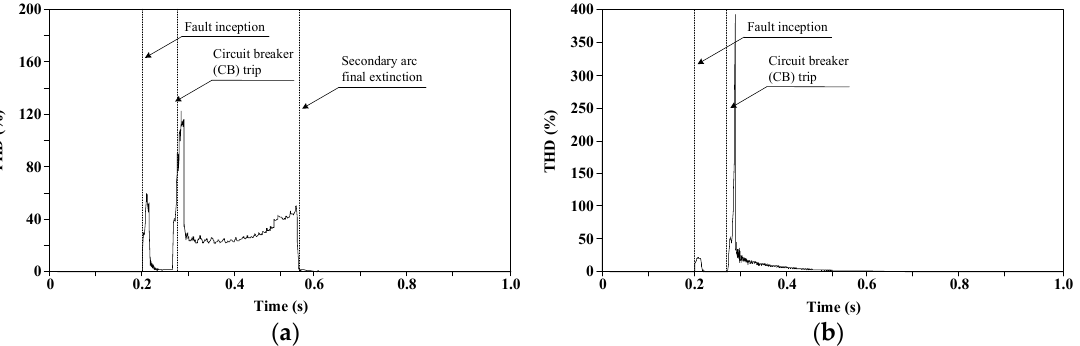
Figure 5. Total harmonic distortion (THD) calculation results for the waveforms shown in Figure 4: ( a ) transient fault; ( b ) permanent fault.